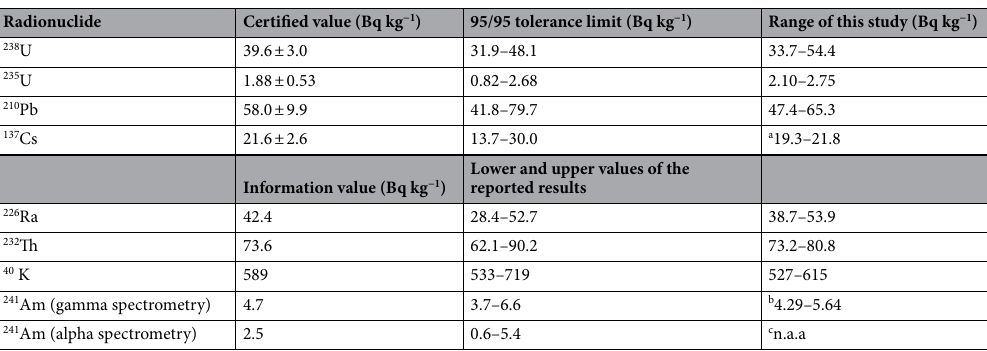
Table 1. The range of analytical results for activity concentration of radionuclides in NIST 4353A (Rocky flat soil) obtained by the detectors used for sample analysis. a The analytical results of 137 Cs were decay corrected to the certified date. b The analytical results of 241 Am were corrected with 241 Am ingrowth from 241 Pu decay and indicated as of the certified date of NIST 4353A. c Not analyzed by alpha